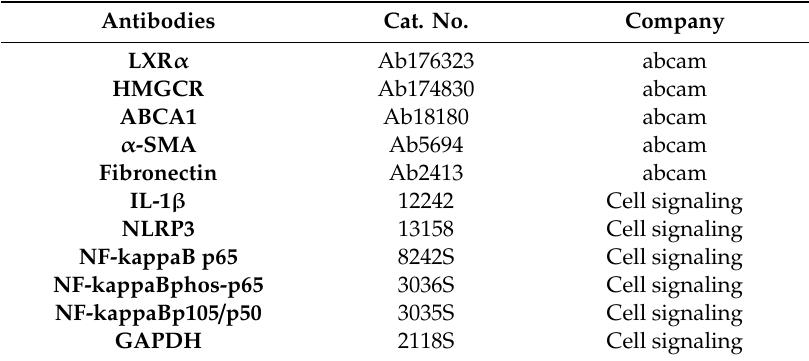
Table 2. List of antibodies used in immunohistochemistry and immunoblotting.